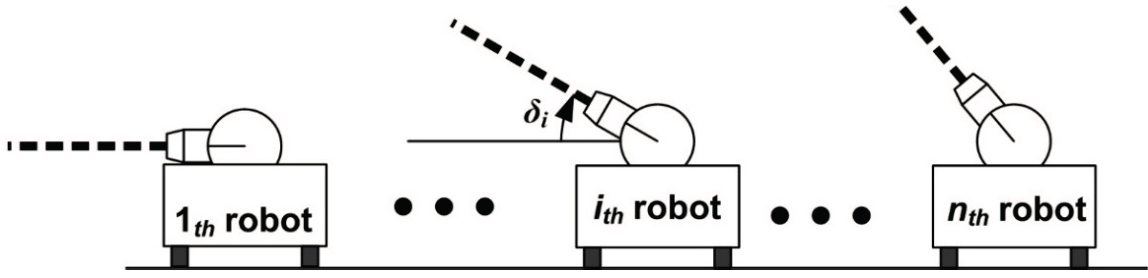
Figure 2. The vertical angles of the range finders on the child